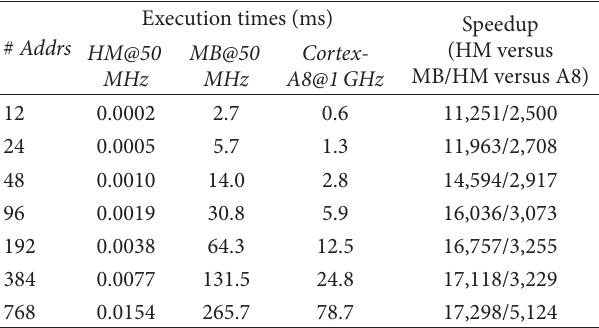
T 4: Execution times for several implementations of the pattern detector for